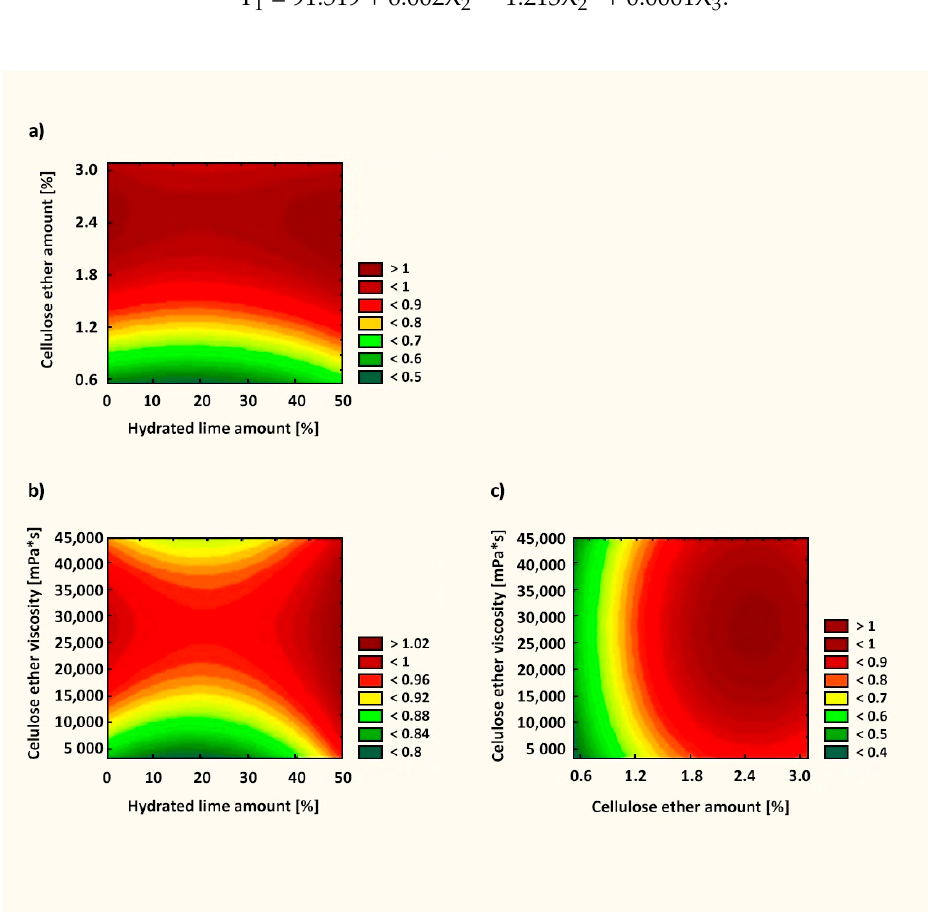
Figure 6. Utility function for the WRV10 test of mortars: ( a ) correlation between cellulose ether amount and hydrated lime amount; ( b ) correlation between cellulose ether viscosity and hydrated lime amount; ( c ) correlation between cellulose ether viscosity and cellulose ether amount.